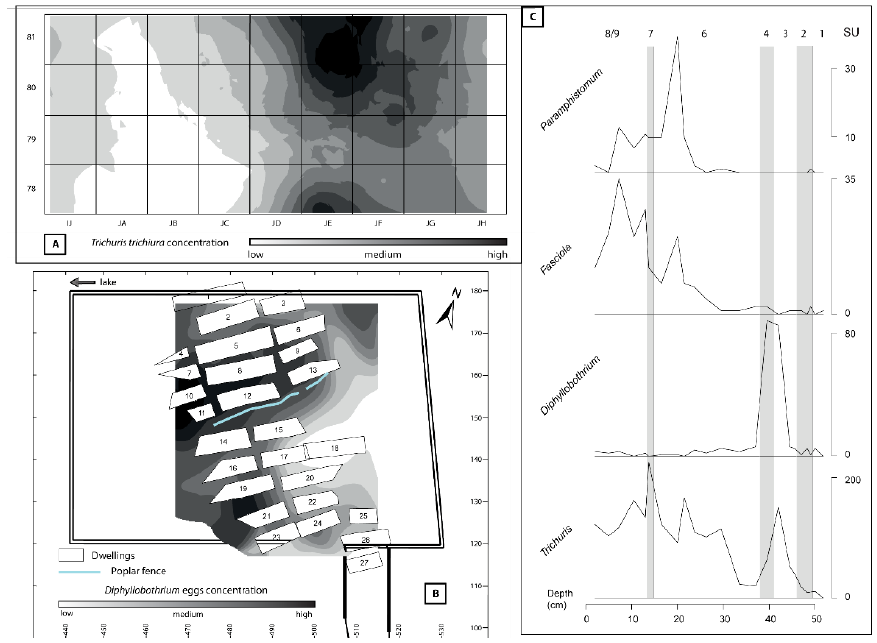
Figure 4. Mapping parasitological residues allow showing concentration areas corresponding to particular rejection zones in archaeological sites. Example in La Draga, Spain ( A ) and Zurich Park- haus Opera, Switzerland ( B ). ( C ) Evolution of the parasite spectrum in Zug-Riedmatt, Switzer-